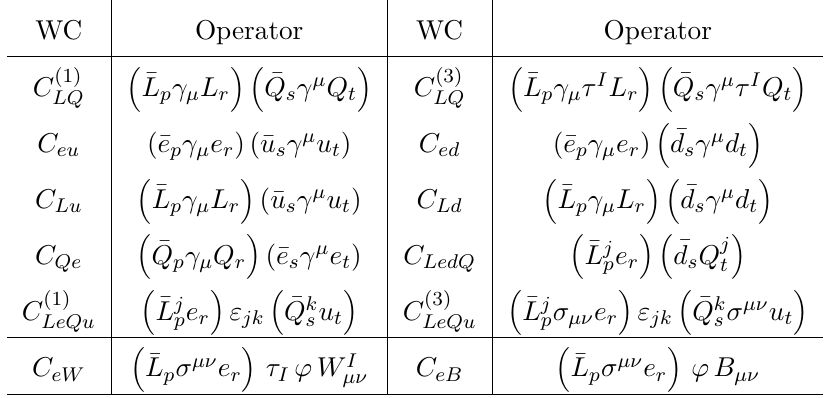
Table 2. Dominant D = 6 SMEFT operators contributing to the CLFV processes generated by leptoquarks. The notation (up to small apparent changes) is the one from ref. [3]. For the family indices, we use p , r , s and t , while j and k are weak isospin indices. For I = 1 , 2 , 3 , τ matrices, with ε = iτ , and σ µν ≡ i [ γ µ , γ ν ] . In the first row, Λ denotes the scale where the 2 2